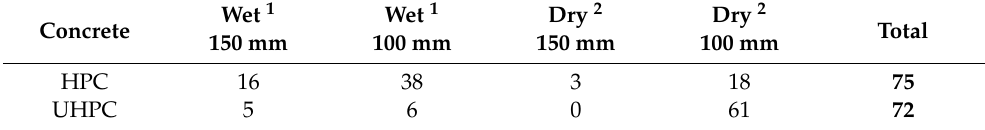
Table A3. Number of cubic compressive strength test results analysed for the characterisation.